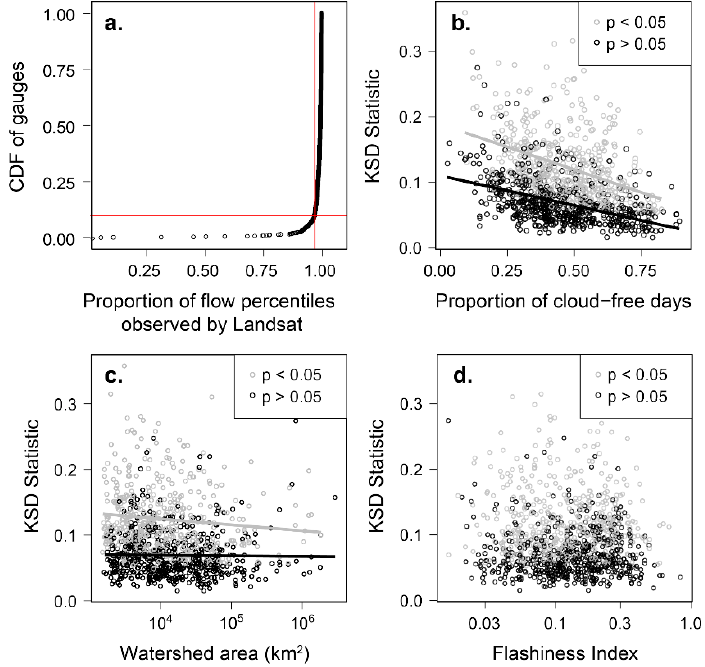
Figure 3. Individual gauge analysis, whereby each point represents metrics at a single gauge station. ( a ) Empirical CDF of the proportion of flow percentiles of the gauge record that the Landsat sample represents at each gauge. ( b ) Cloud occurrence correlates negatively with the ability of Landsat to capture flow frequency as represented by the KSD statistic. ( c ) Watershed area weakly correlates with the KSD statistic. ( d ) The Richards–Baker Flashiness Index does not correlate with the KSD statistic.